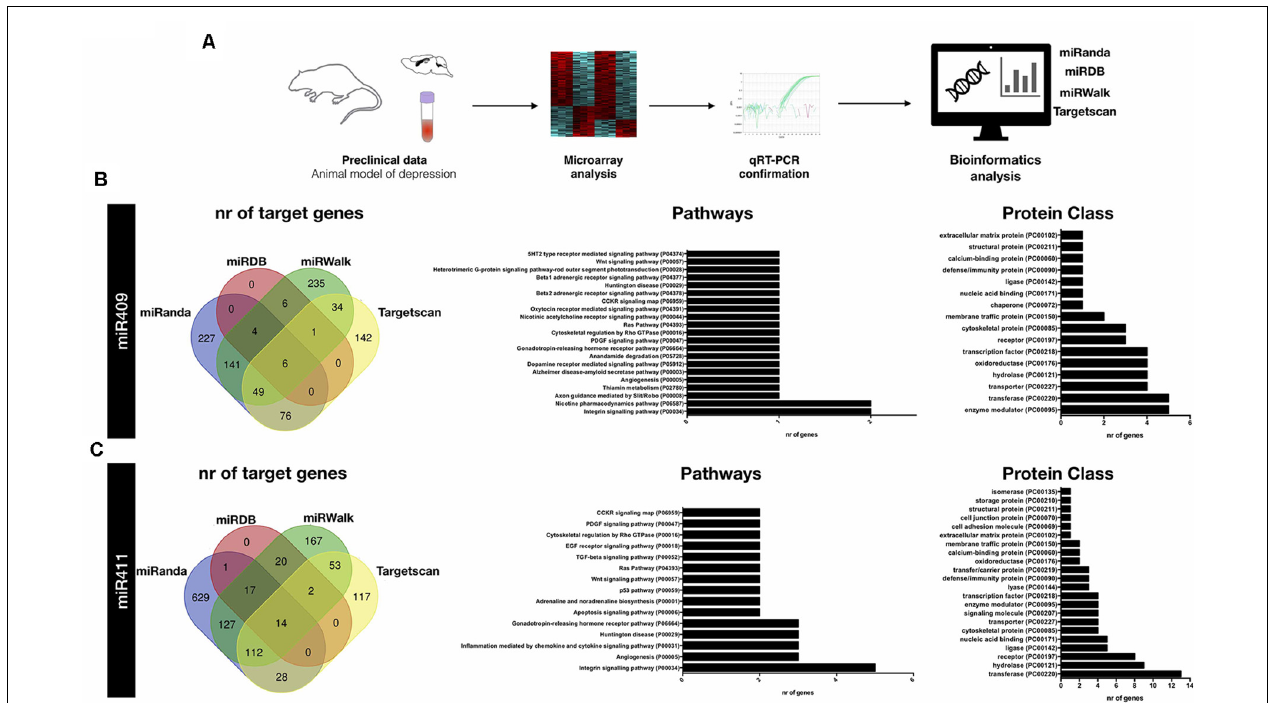
FIGURE 2 | Bioinformatics analyses of miR-409-5p and miR-411-5p target genes. (A) Schematic representation of the experimental approach used to identify and analyze miR-409-5p and miR-411-5p target genes. (B,C) Venn diagrams depicting the number of target genes identified by each of the miRNA target prediction tools: miRanda, miRDB, miRWalk and TargetScan (left panel), and list of the top significantly enriched pathways and protein classes identified by PANTHER database (right panel) for (B) miR-409 and (C) miR-411 target genes, respectively. The target genes predicted by three out of the four miRNA target genes predicting tools were used as input in the PANTHER